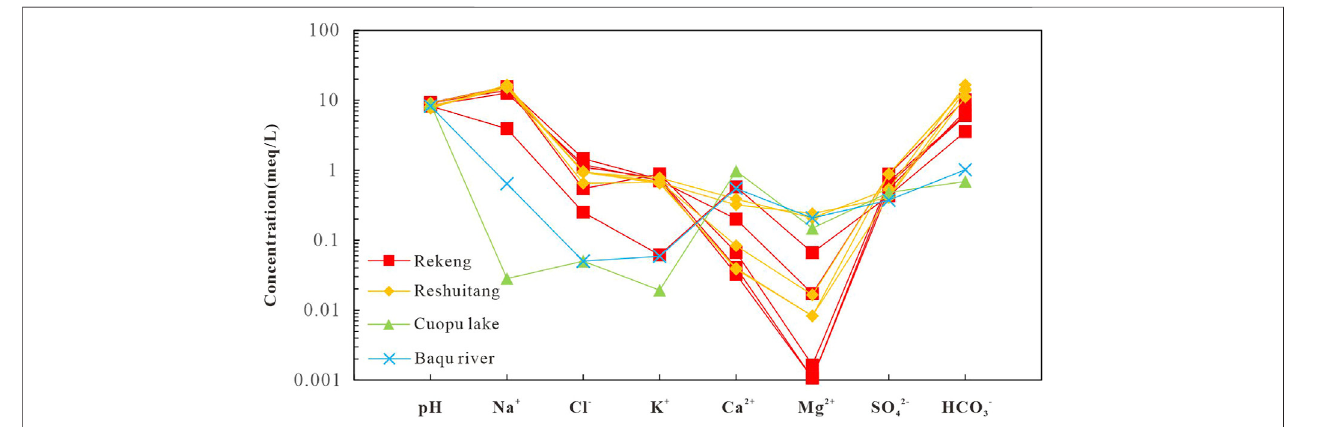
FIGURE 3 | Schöeller ’ s diagram for different water samples in the study area.